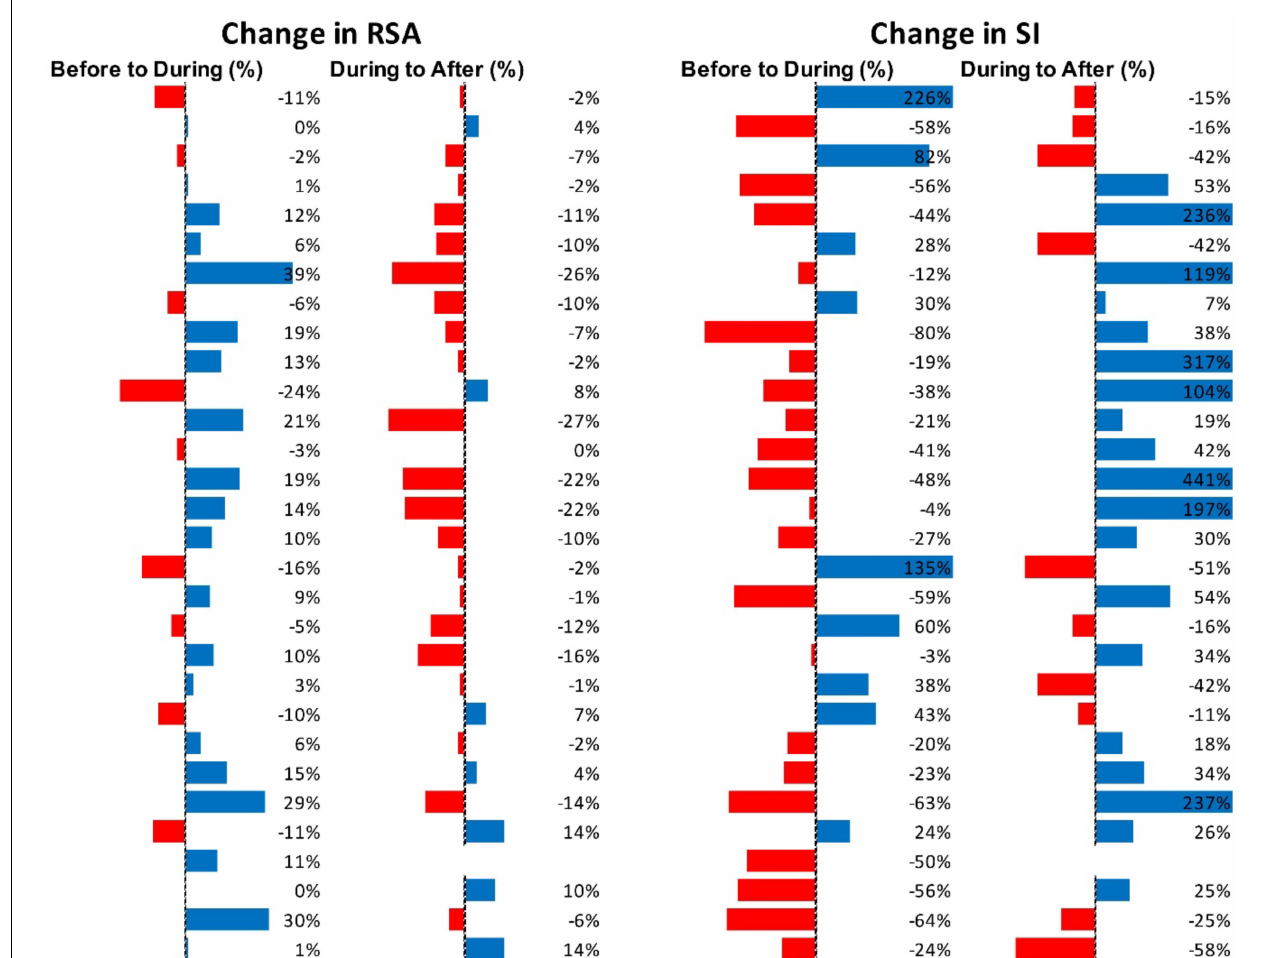
FIGURE 11 | Changes in autonomic activity in response to all SPW’s ( N = 30). Data are shown as % change. The Friedman test was applied for assessment of significance followed by Dunn’s multiple comparisons test. RSA: before to during, ns; during to recovery, p = 0.0142. SI: before to during: ns.; during to recovery, p = 0.0021